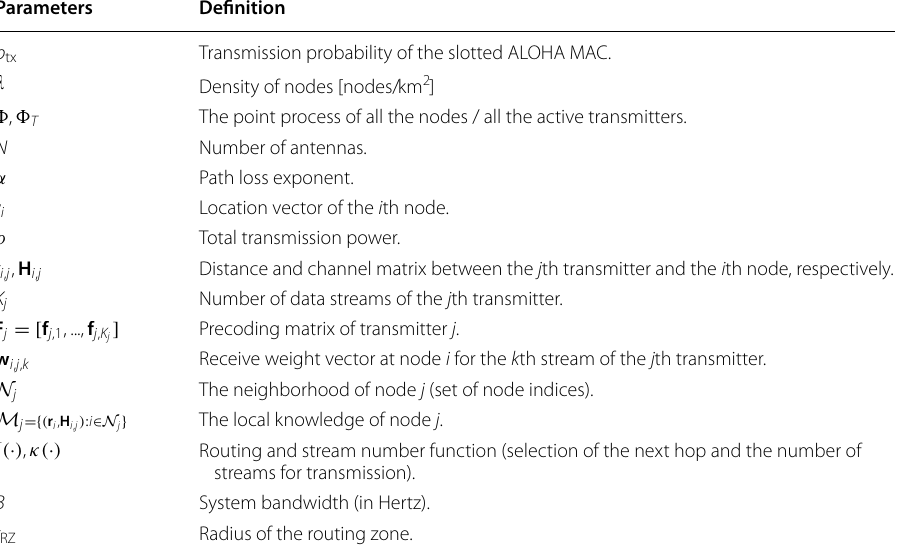
Table 1 Definitions of parameters and variables